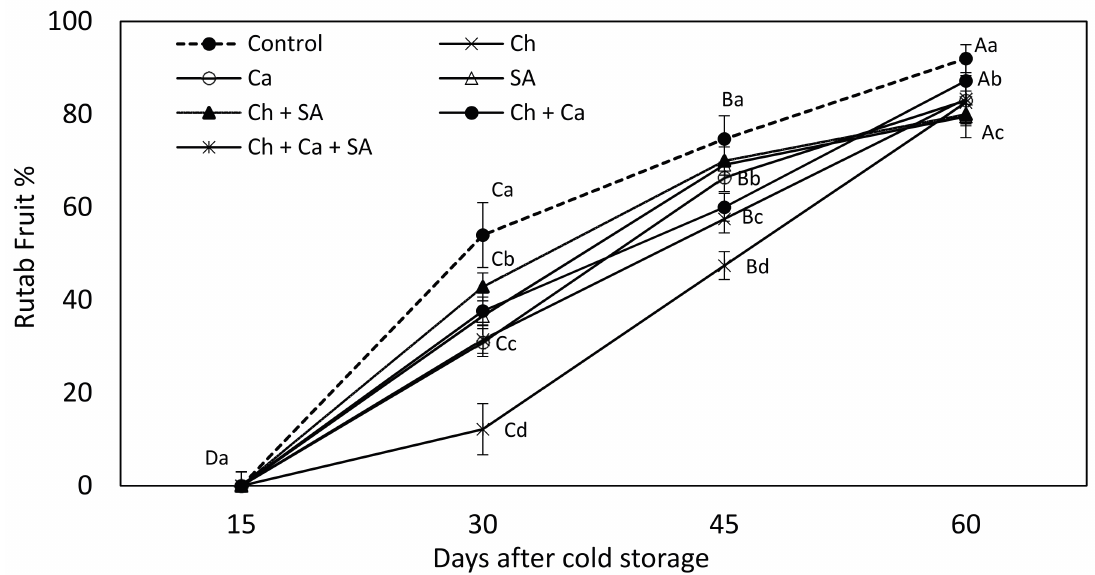
Figure 3. Effect of different preharvest treatments on ‘Khesab’ fruit ripening (Rutab %) during cold storage. Values are the mean ( n = 25) ± SE. Means with different letters between treatments (small letter) at different time interval (capital letter) are significantly different at p < 0.05 using LSD test. Ch: chitosan; Ca: calcium chloride; SA: salicylic